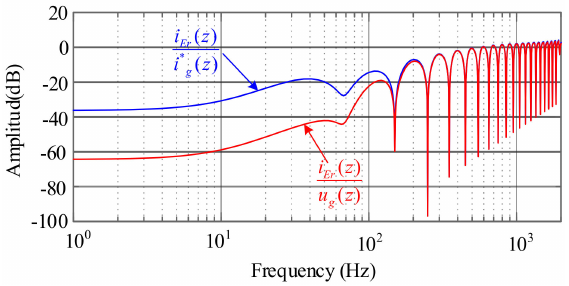
Figure 14. Curves of amplitude-frequency characteristics of control error transfer function of com- pound